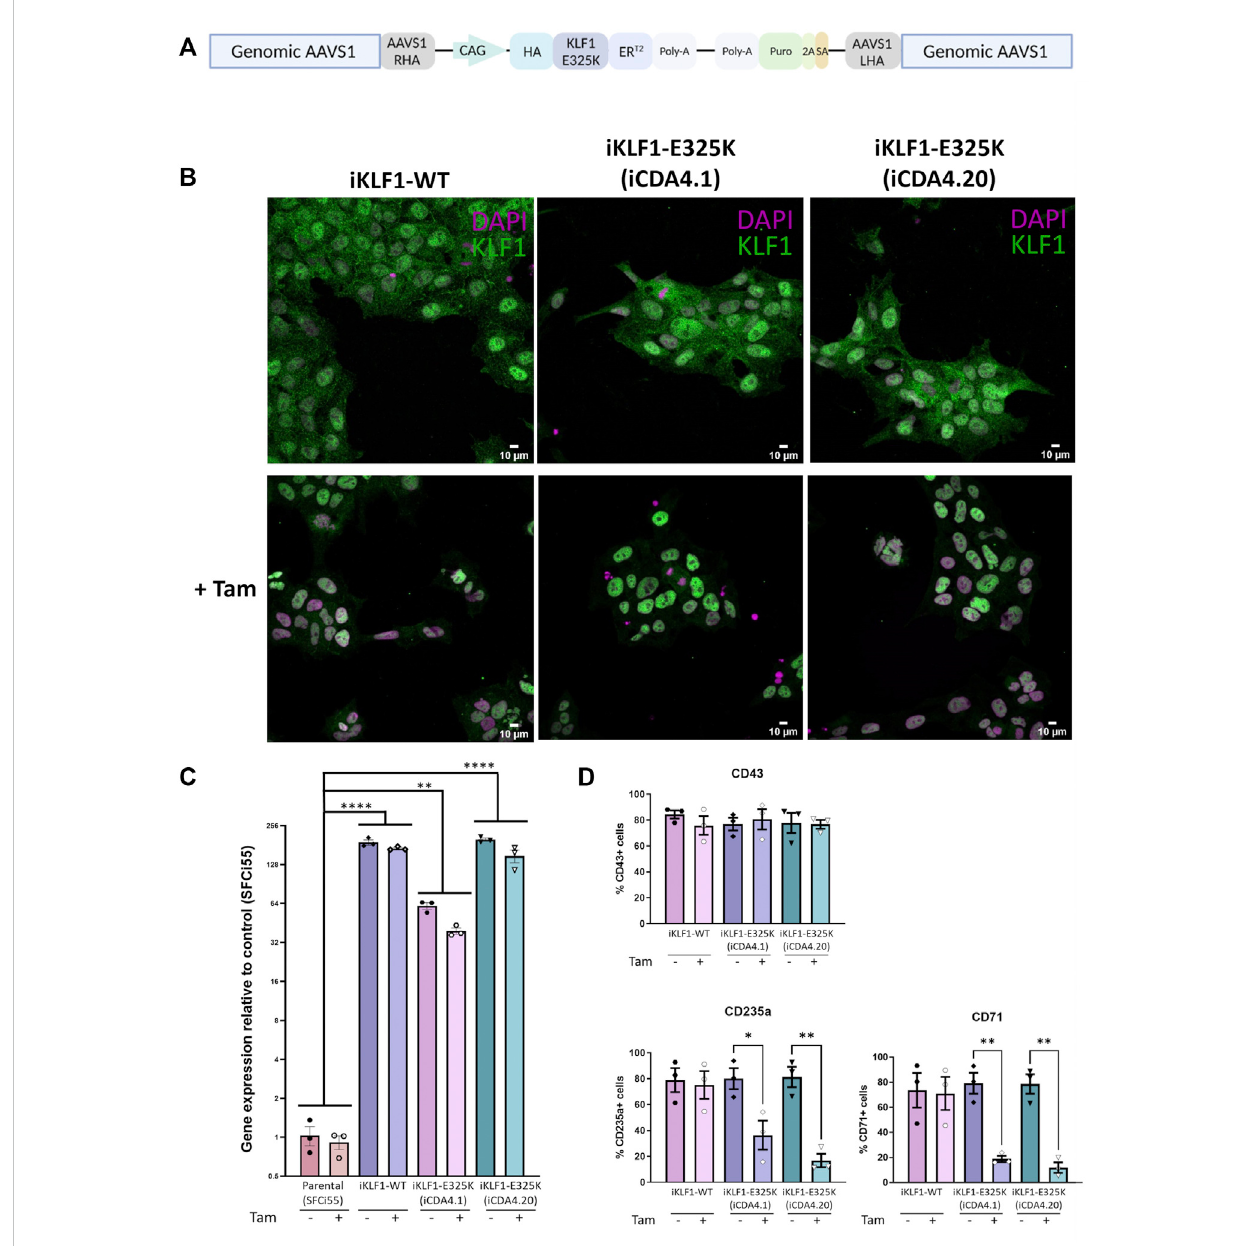
FIGURE 2 Inducible KLF1-E325K activation iPSC lines provide an alternative model for CDA. (A) Schematic of the pZDonor-AAVS1-Puro-CAG-HA-KLF1- E325K-ERT2-PolyA construct integrated into the AAVS1 safe-harbor locus. (B) Immuno fl uorescence staining of iPSCs from one inducible KLF1-WT (iKLF1-WT, iKLF1.2) and two inducible KLF1-E325K (iKLF1-E325K, iCDA4.1 and iCDA4.20) iPSC lines stained with an anti-KLF1 antibody (green) and the DAPI nuclear dye (magenta) in the presence (bottom panel) and absence (top panel) of 4OH-tamoxifen. 10 µM scale bar. × 40 magni fi cation. (C) ExpressionofendogenousandexogenousKLF1-WT/KLF1-E325KusingqRT-PCRinRNAlysatestakenfromaniKLF1-WTandtwoiKLF1-E325KiPSClines. Fold change relative to the parental control line (SFCi55). Error bars represent SEM. One-way ANOVA with Tukey post-test. * p < 0.05, ** p < 0.01, *** p < 0.0001. Datapoints represent individual iPSC harvests. (D) Quanti fi cation of fl ow cytometry analyses of cell surface expression of CD43, CD235a and CD71 of suspension cells harvested from erythroid differentiations of iKLF1-WT and iKLF1-E325K iPSCs. Suspension cells were analysed on the day they were harvested. Datapoints represent individual suspension cell harvests. Error bars represent SEM. One-way ANOVA with Tukey post-test. * p < 0.05 ** p <